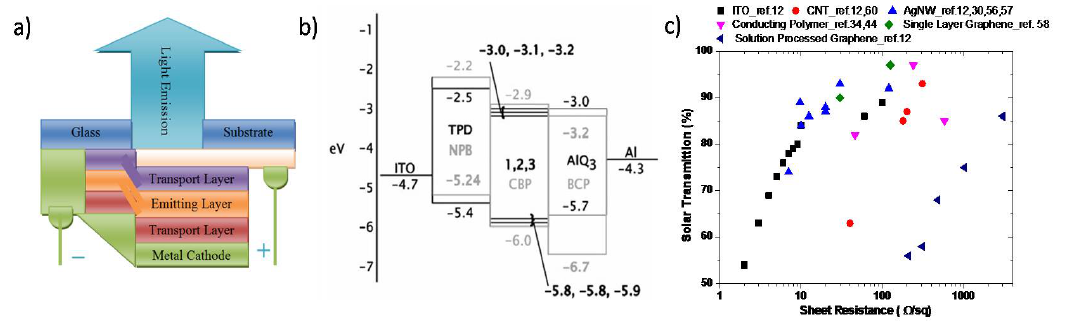
Figure 1. ( a ) Schematic diagram of the organic light emitting diode (OLED) structure; ( b ) engery level diagram of a simple OLED device consisting of N,N ′